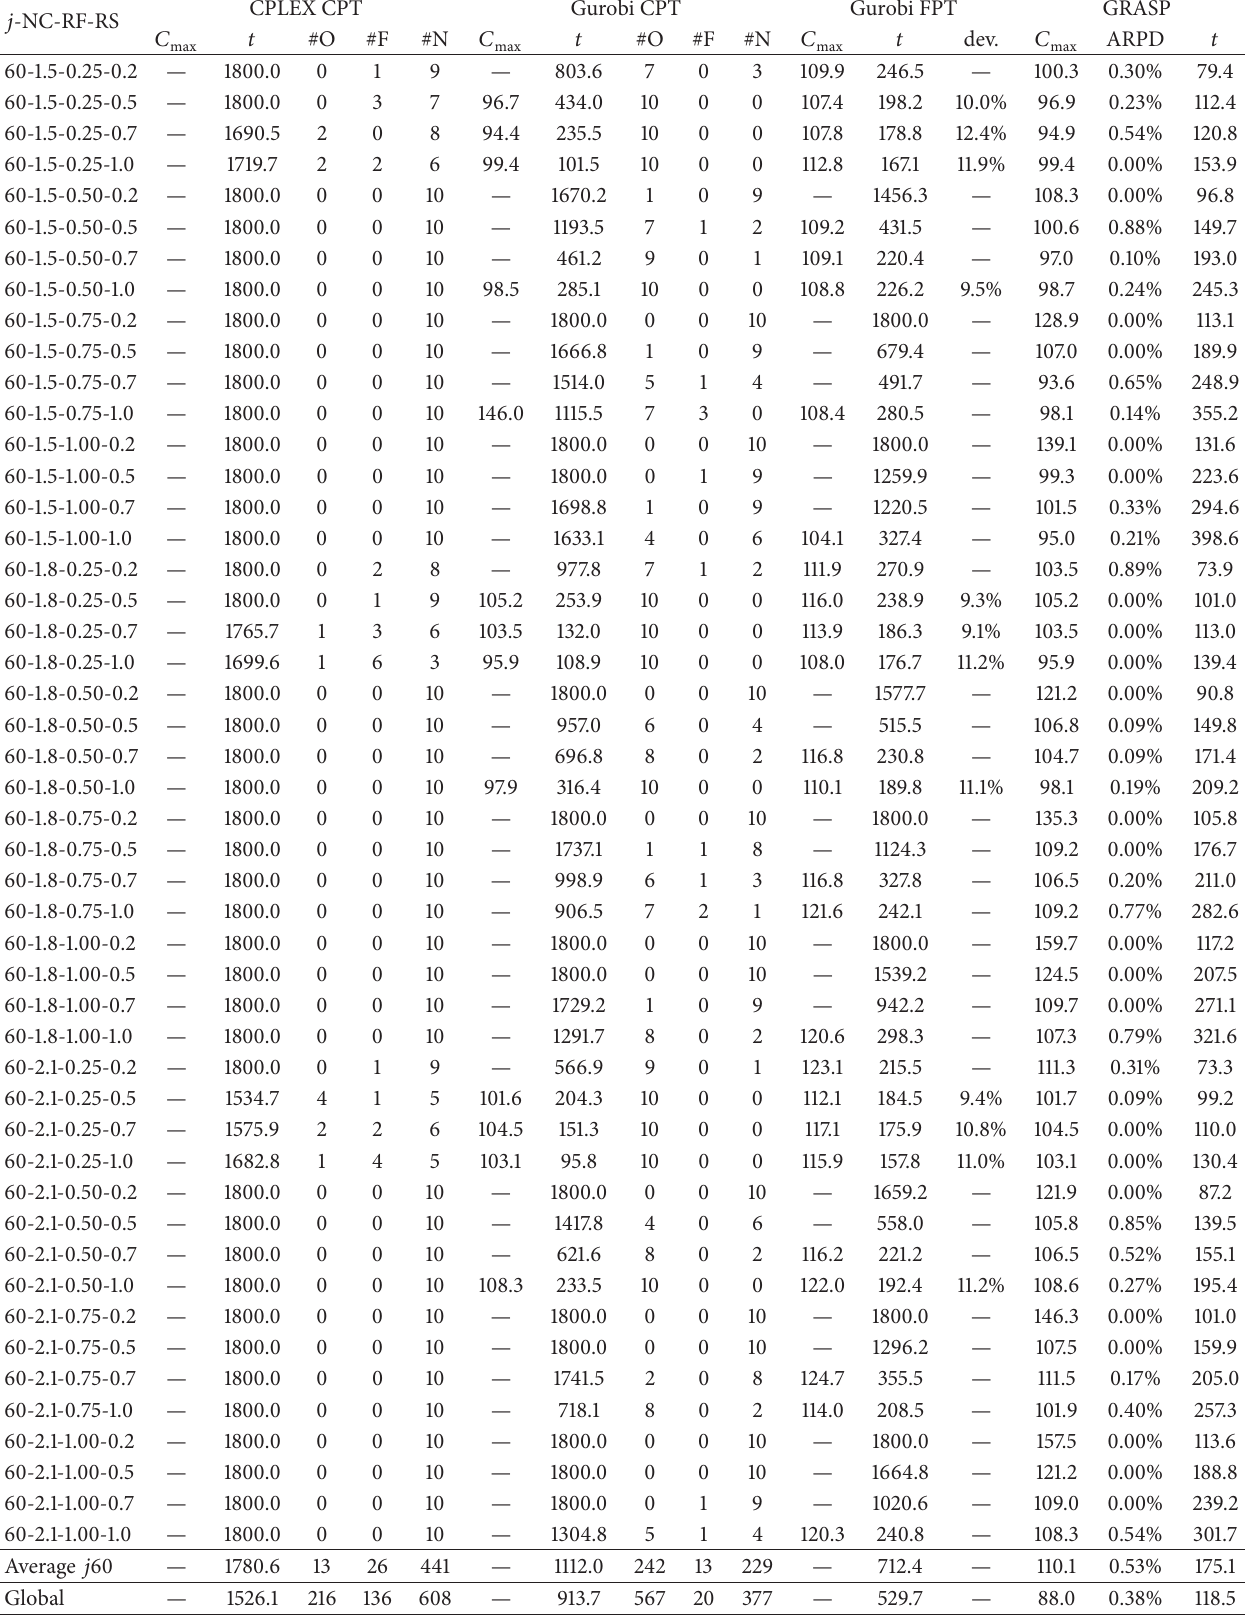
Table 7: Experimental results for 60